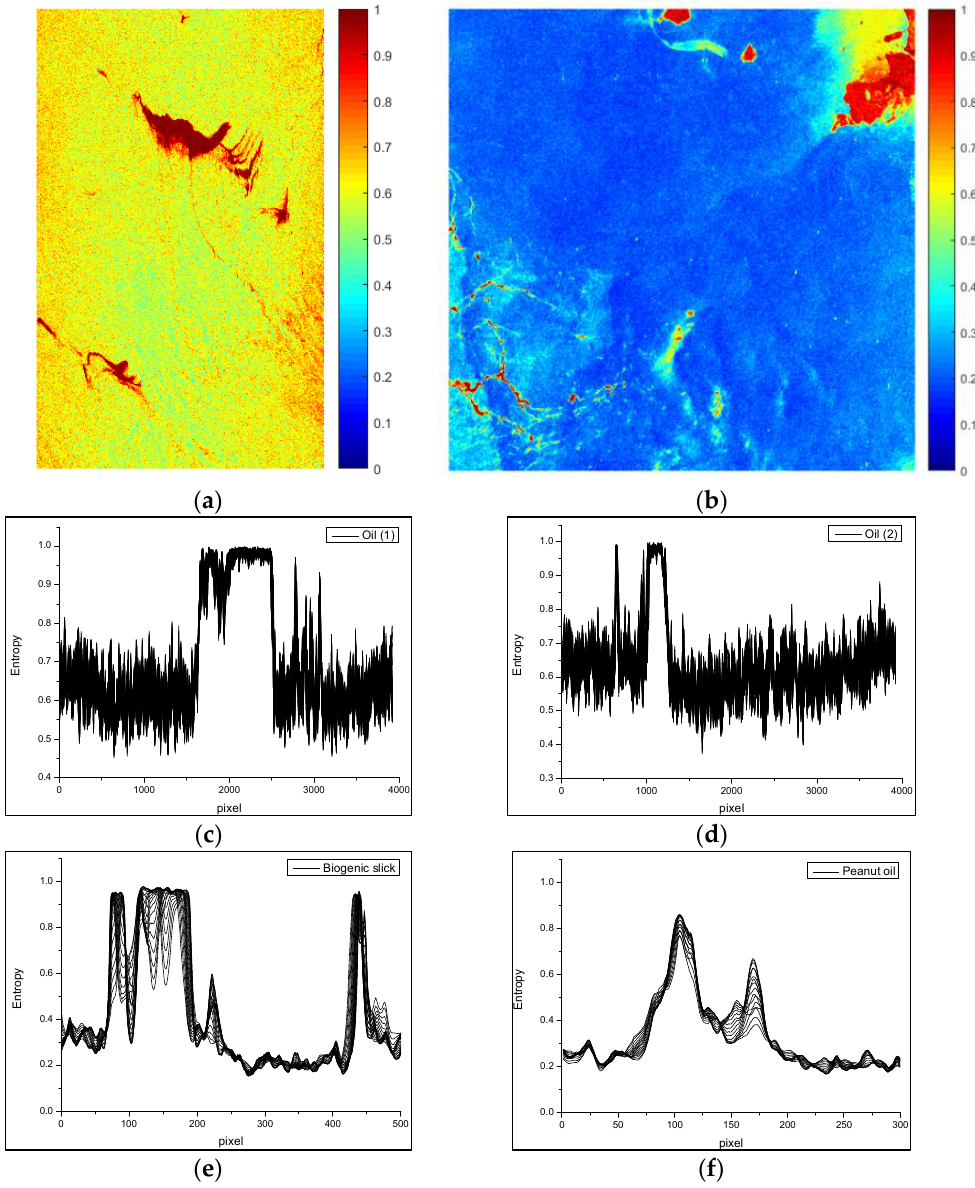
Figure 5. Entropy (H) values from RADARSAT-2 images of the natural oil seep ( a ) and the biogenic and peanut oil slicks ( b ); ( c – f ) the H values for the four green rectangular areas (oil (1), oil (2), biogenic slick, and peanut oil, respectively) that are indicated on the SAR images in Figures 2 and 3.